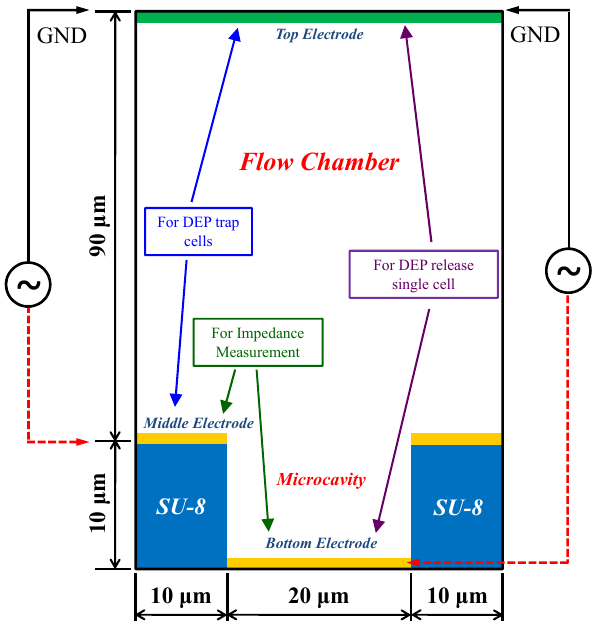
Figure 1. The 2D and 3D model of multilayer electrodes DEP chip; the height of the flow chamber is 90 μ m, the thickness of SU-8 layer is 10 μ m and the diameter of the cavity is 20 μ m.